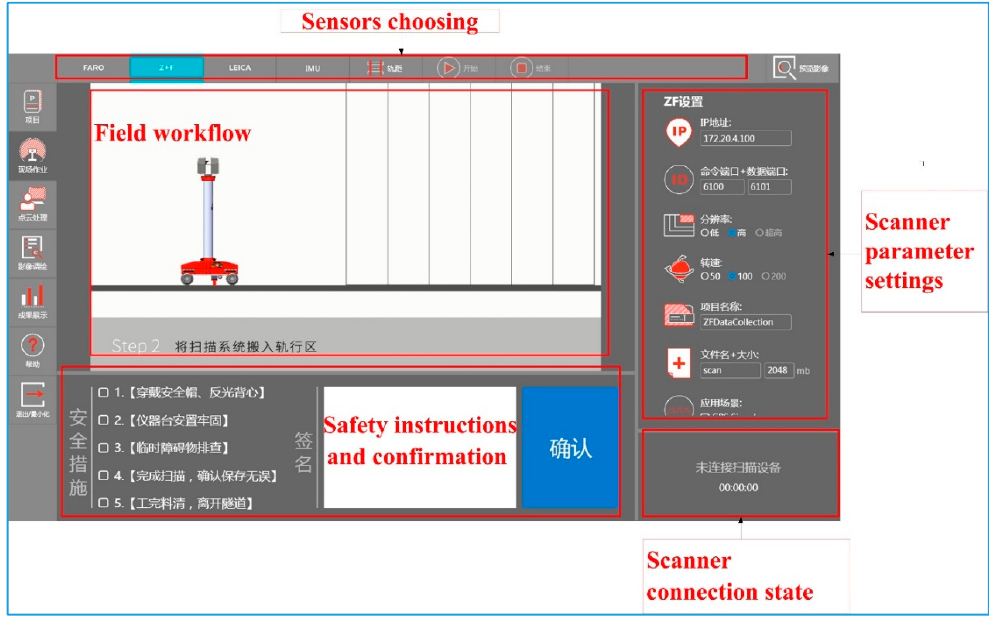
Figure 2. Interface design of the data acquisition module.